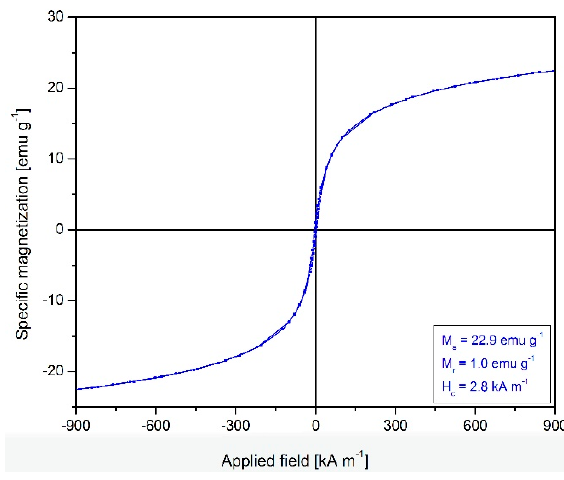
Figure 2. Magnetic hysteresis curve of the Fe 3 O 4 @C matrix.